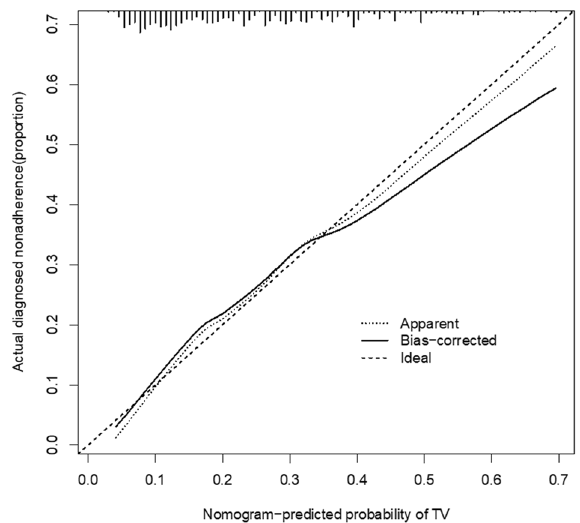
Figure 3. Calibration curves for the ability to predict TV using the nomogram in the cohort.